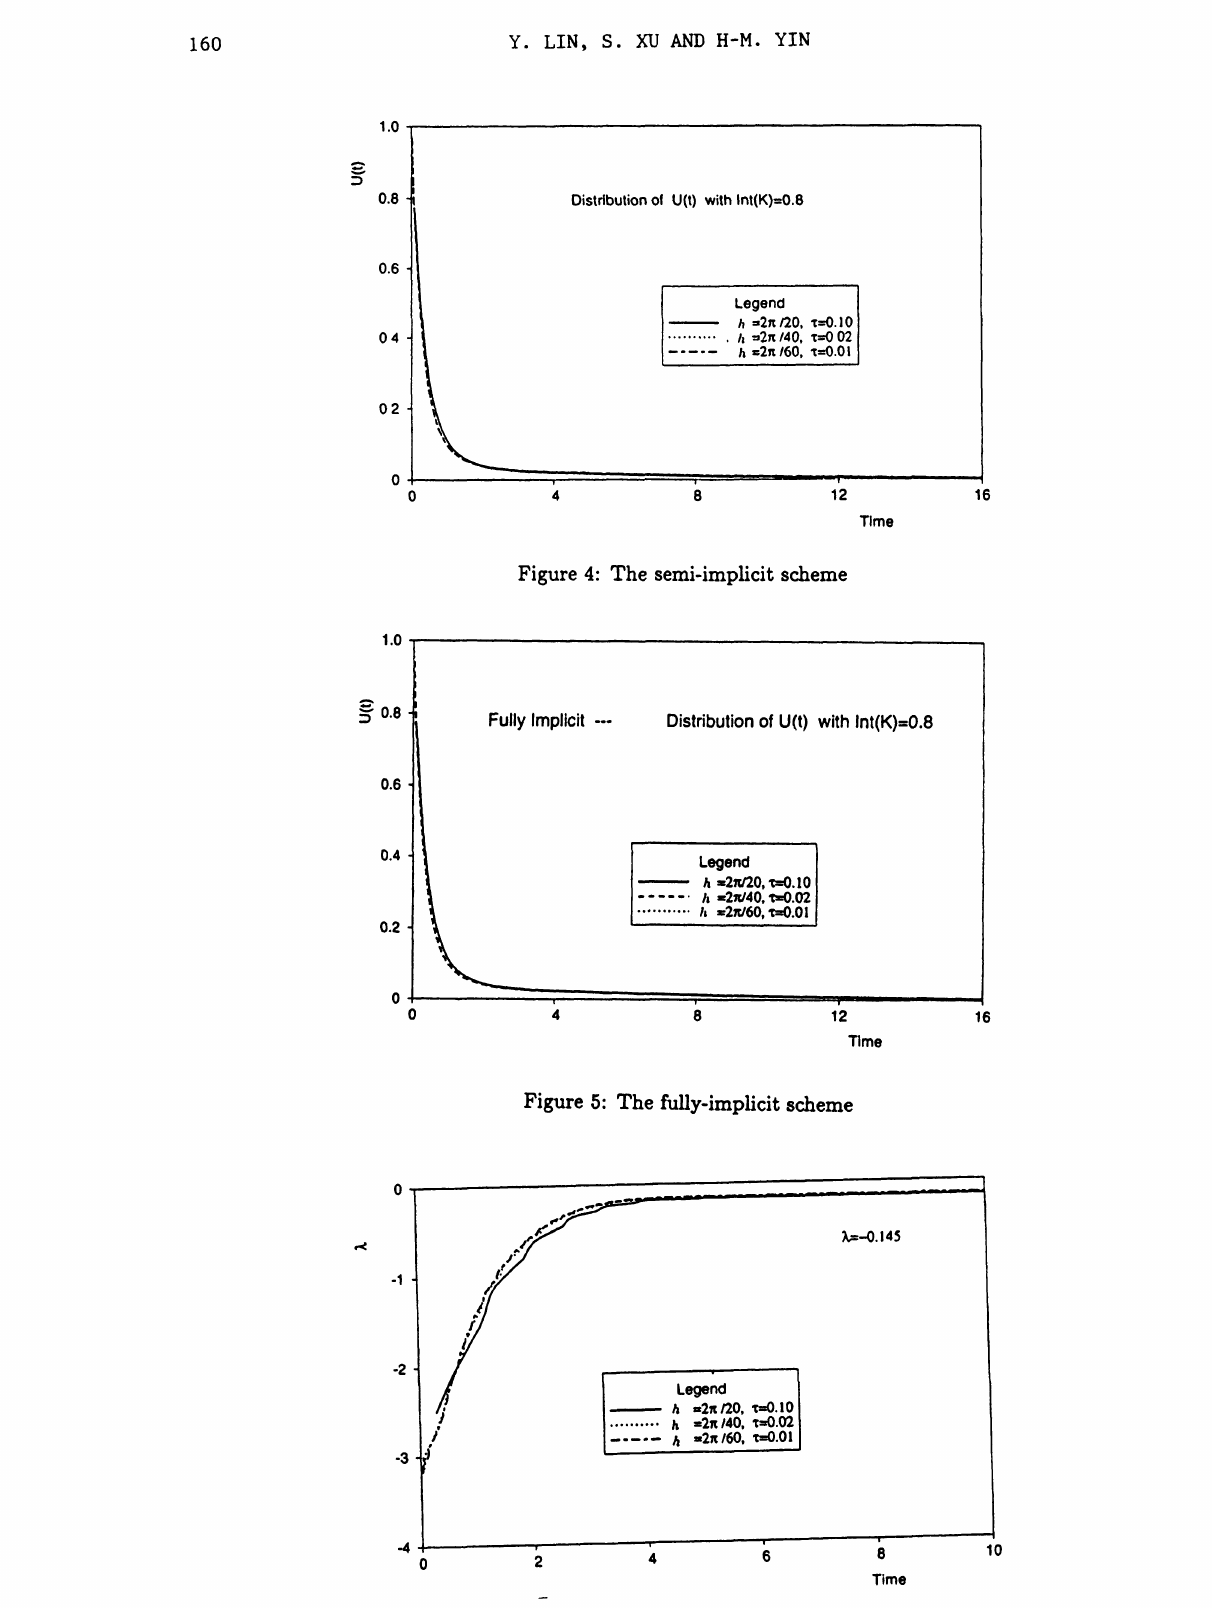
Figure 6: The semi-implicit